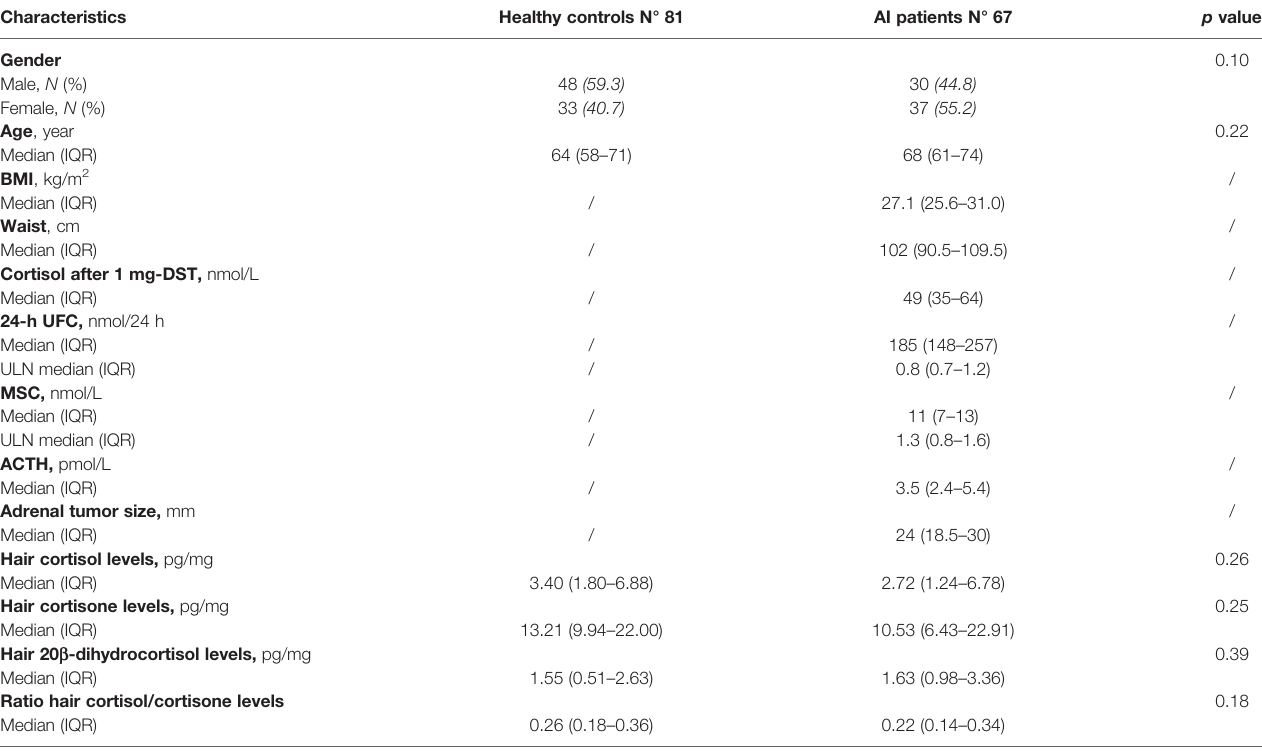
TABLE 3 | Baseline characteristics of healthy subjects and patients with